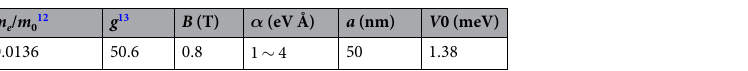
Table 1. The parameters of a 1D InSb quantum dot used in our calculations ( m 0 is the electron